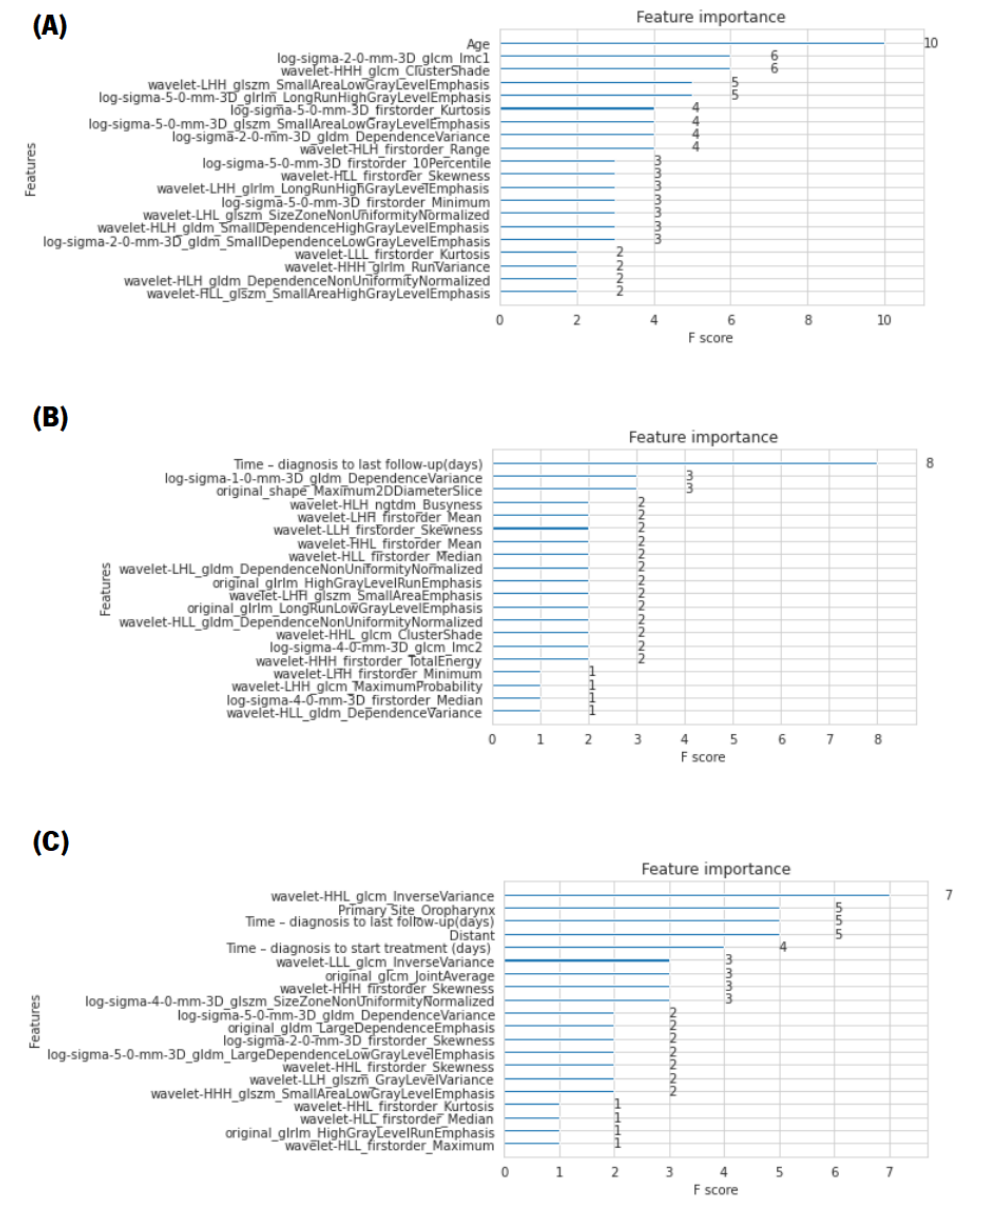
Figure 6. Bar charts with the importance score given to the 20 most-relevant features of the best results. ( A ) For the LR prediction, it is not only noteworthy that the feature with the most influence is age, but also the fact that its F-score is very high, compared to the other features. ( B ) For the construction of the decision trees of the model of DMs, predominantly, features extracted after the application of the wavelet filter were used, demonstrating that the multiscale texture feature analysis of the tumour performed with the application of this filter was decisive in predicting DMs. In addition, the variable with the highest decision weight was the time from diagnosis to the last follow-up. ( C ) Regarding the OS prediction, it can be seen that the presence of distant metastases was a crucial factor for the prediction of OS. Another relevant feature was the primary site of the tumour, more specifically when it was oropharynx. It can also be concluded that the time, in days, from diagnosis to the last follow-up and to the start of treatment were also features with great influence on the construction of the model decision